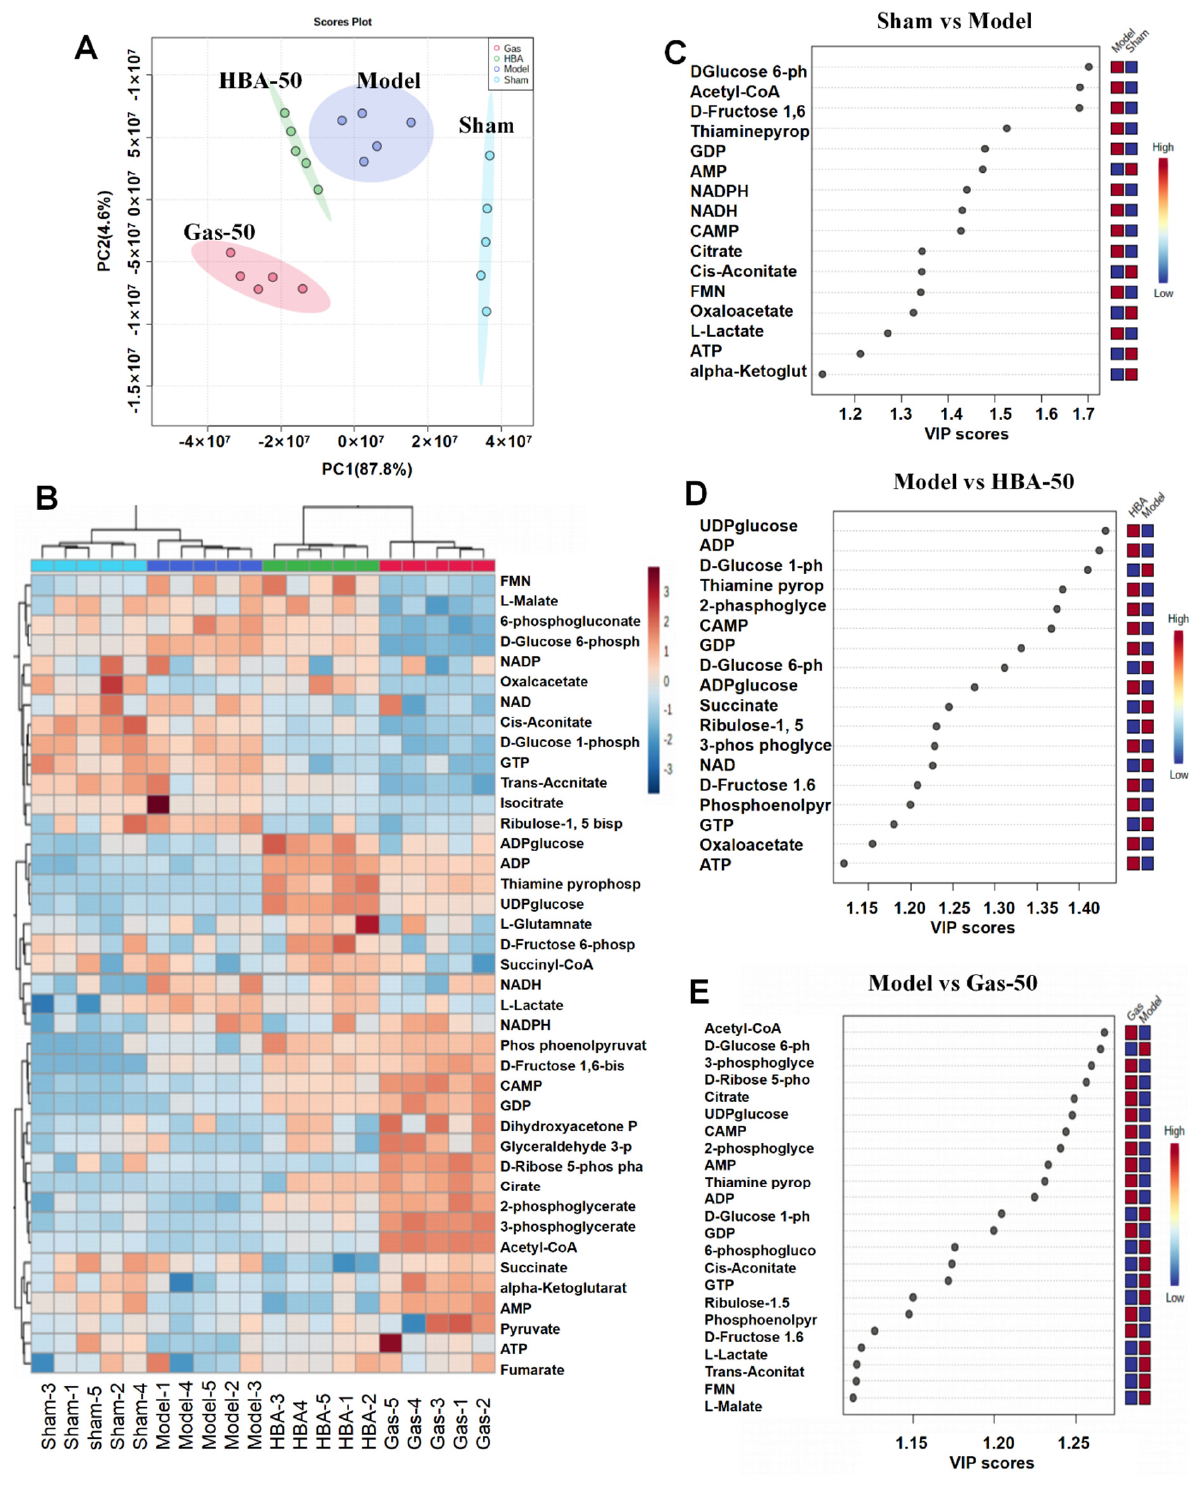
Figure 4. Gas and HBA improve the energy metabolism pattern of the brain. ( A ) PCA model score plot; ( B ) Heat map of 40 energy metabolites in brain tissue (red indicates upregulation, blue indicates downregulation); ( C ) VIP plot of Sham vs. Model; ( D ) VIP plot of Model vs. HBA-50; ( E ) VIP plot of Model vs. Gas-50.